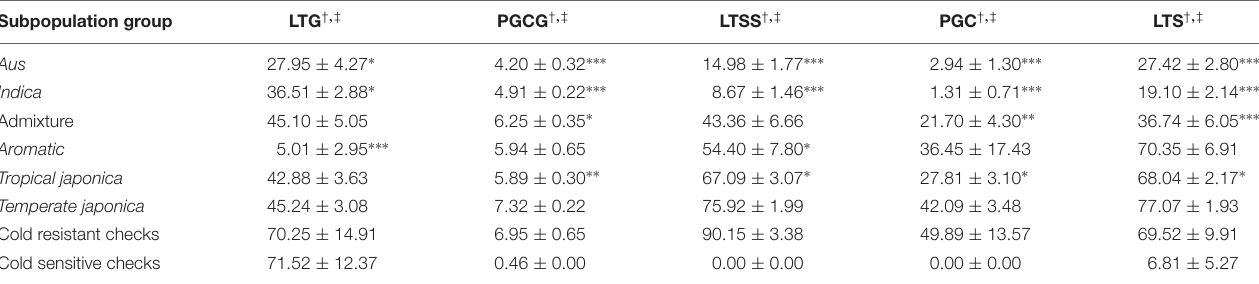
TABLE 1 | Means and standard error for the five seedling chilling tolerance indices by the five rice subpopulation groups and the admixture of two or more subpopulations. Subpopulation group LTG † , ‡